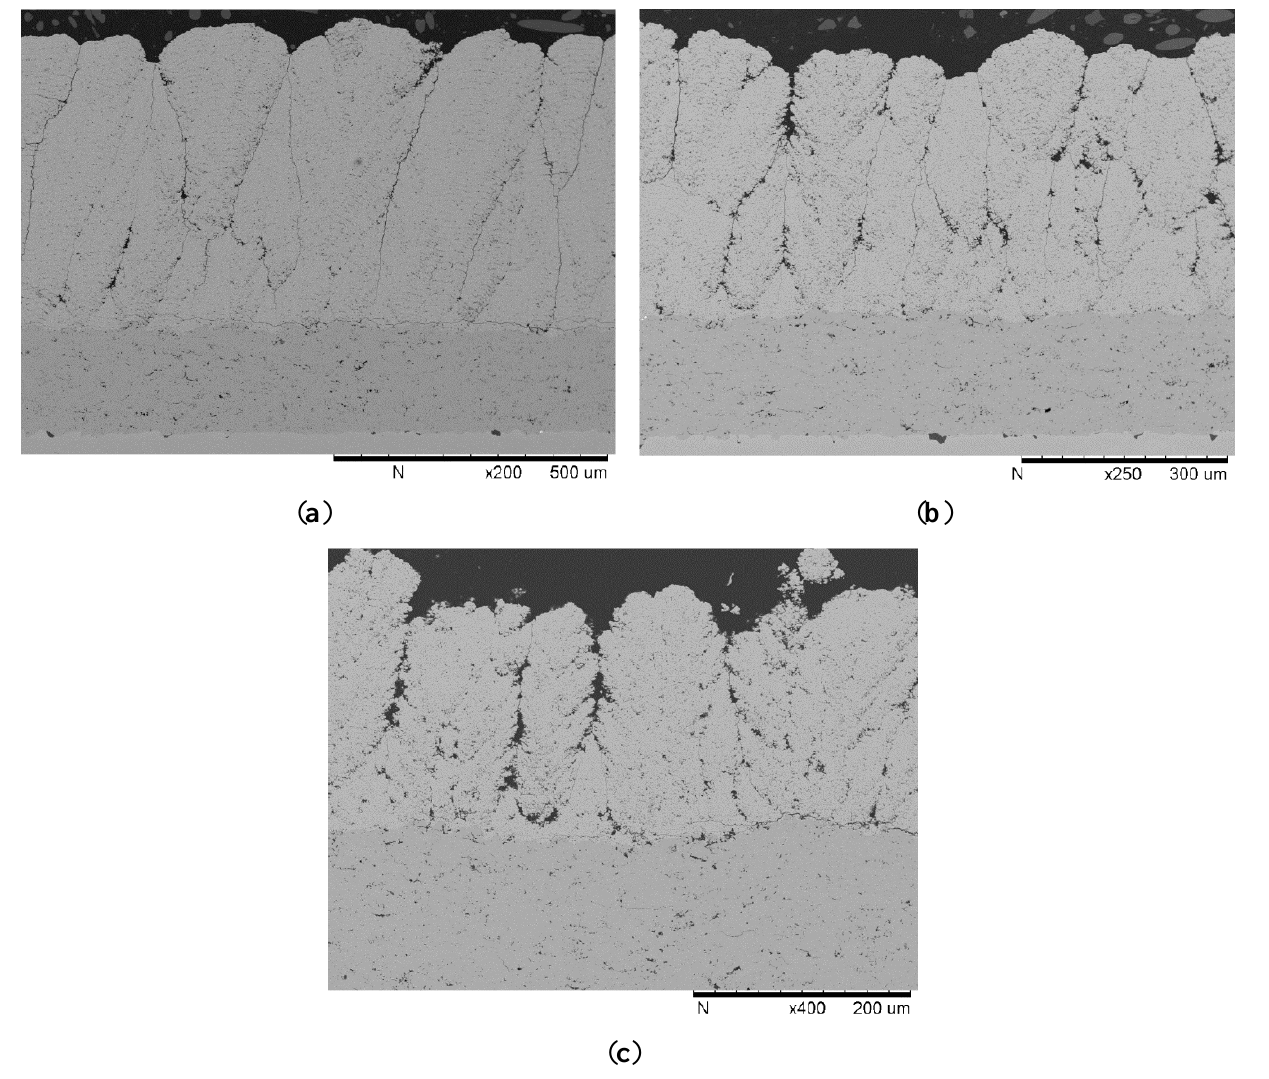
Figure 5. Coatings: ( a ) T2, 33% solids load; ( b ) T3, 25% solids load; and ( c ) T4, 17% solids